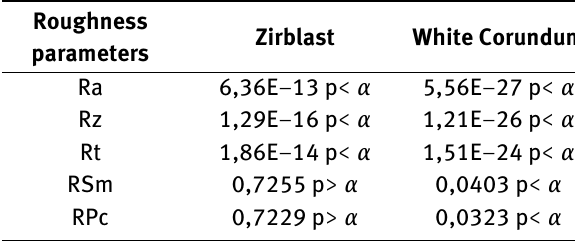
Table 7: p-values for the individual parameter.